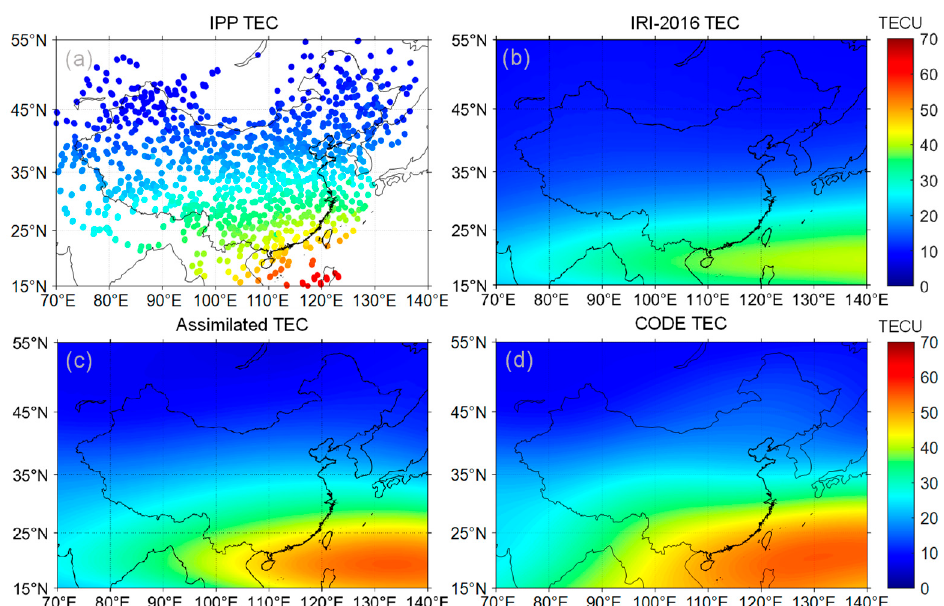
Figure 6. Comparison plot at 05:00 UT for a disturbed day on 8 September 2017. ( a ) is derived from GNSS observations; ( b ) is derived from IRI-2016 model; ( c ) is derived from assimilated method of the improved ensemble Kalman filter; ( d ) is derived from CODE.